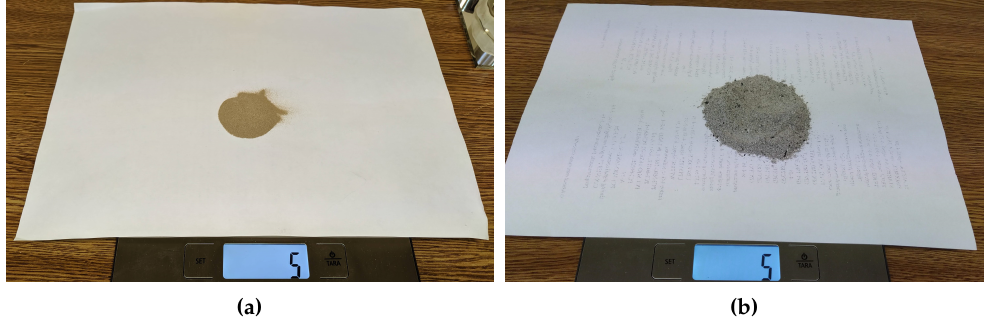
Figure 6. Weighing of the pollutants. ( a ) Fine sand, ( b ) ash. In both cases, the pollutant weighs